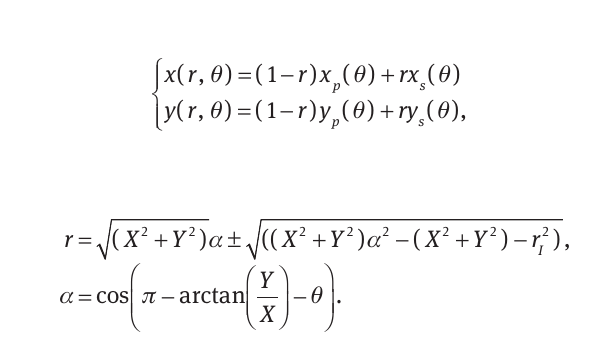
Figure 14. Summary of the Normalization Process.